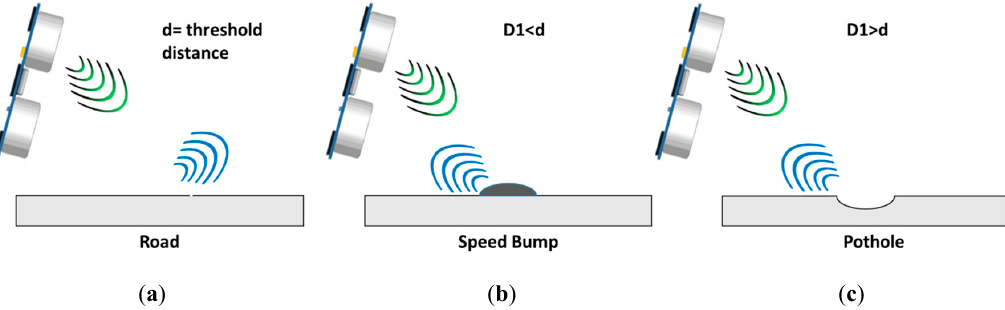
Figure 2. Working of ultrasonic sensor, ( a ) Plain road, ( b ) Speed bump, and ( c ) pothole.